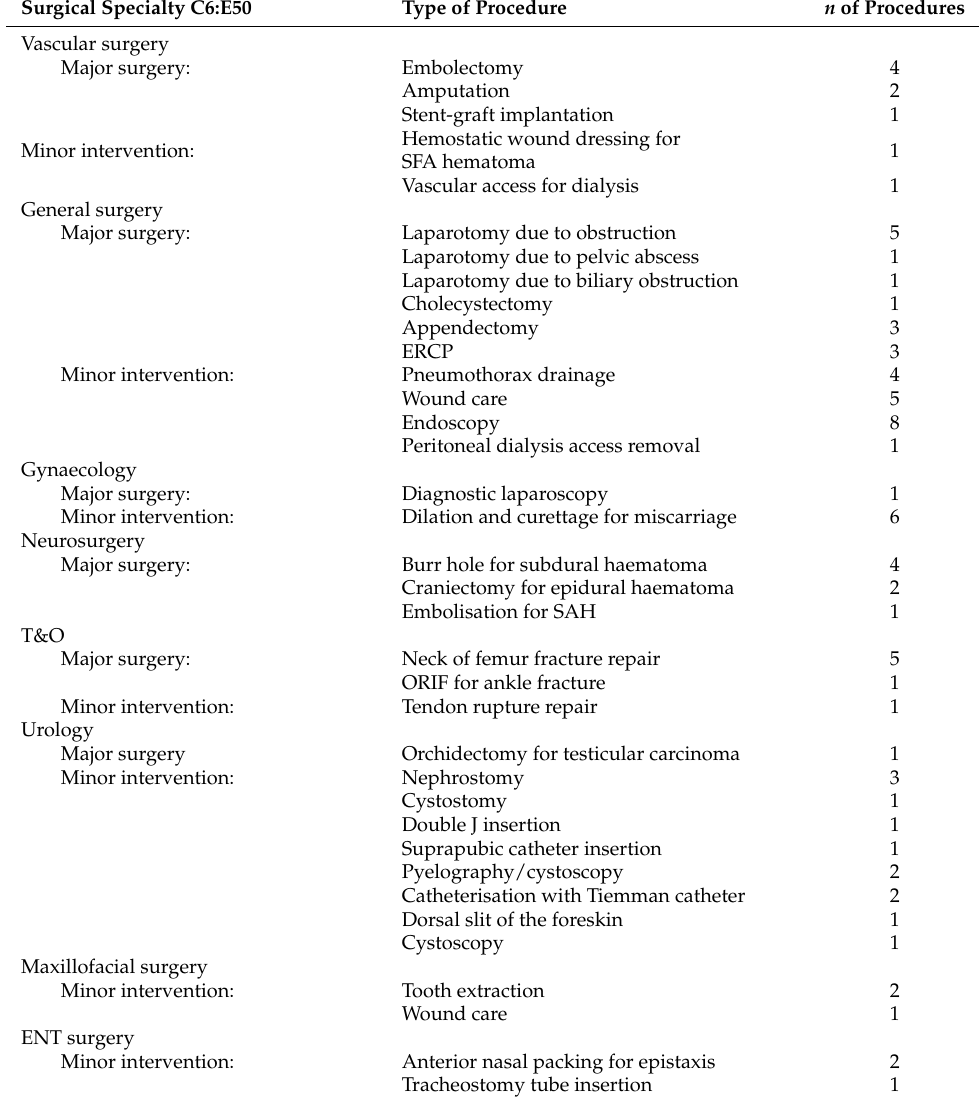
Table 1. Types of surgical procedures performed on patients infected with Coronavirus Disease 2019 (COVID-19). No missing data. ENT, ear, nose, and throat; T&O, trauma and orthopaedic. Surgical Specialty